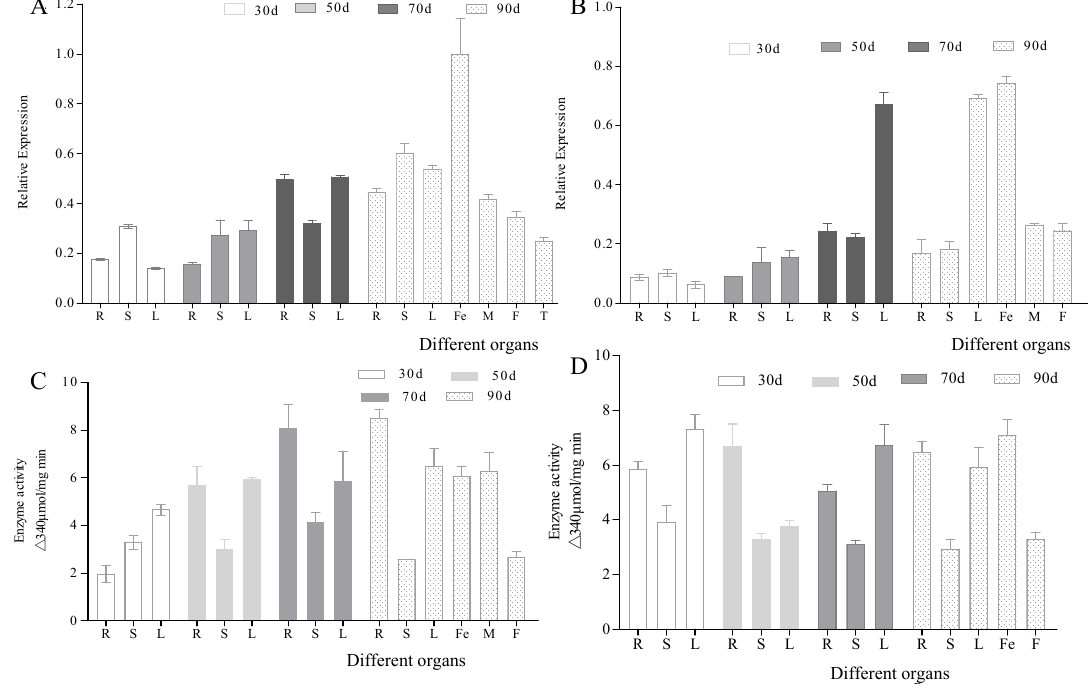
Figure 8. CsHPL gene expression and HPL enzyme activity in the different organs of cucumber. ( A ) The relative expression of CsHPL gene in No. 26; ( B ) The relative expression of CsHPL gene in No. 14-1; ( C ) The 13-HPL enzyme activity in No. 26; and ( D ) The 13-HPL enzyme activity in No. 14-1. The bars represent gene relative expression or enzyme activity in different organs of cucumber. The error bars are the standard deviations from three biological repeats. R, Root; S, Stem; L, Leaf; Fe, Female flower; M, Male flower; F, Fruit; T, Tendril.